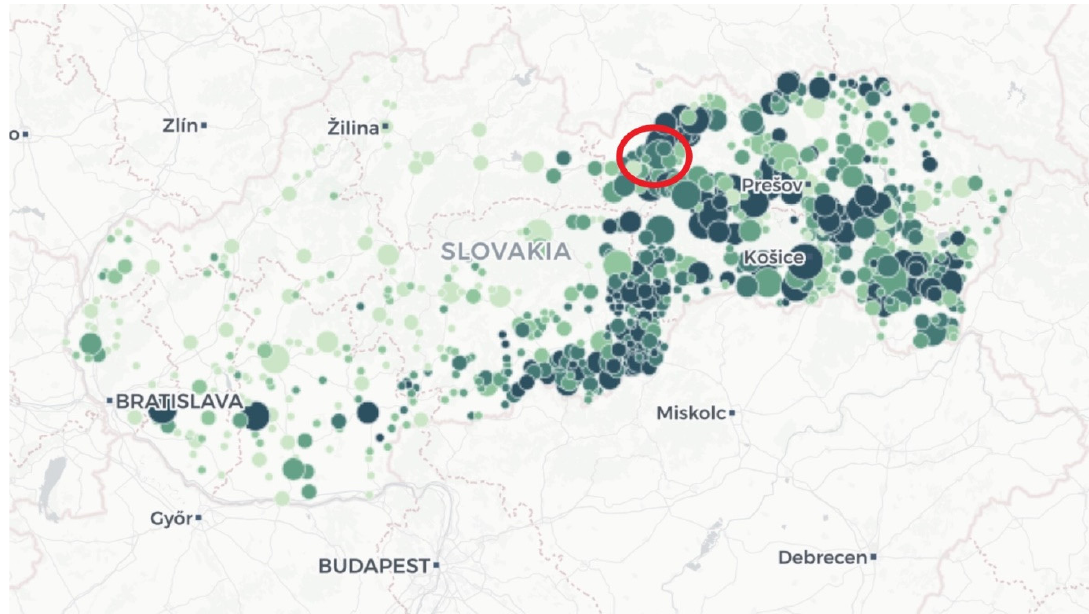
Figure 2. Where do Roma live? Slovakia, showing the district of Poprad (red circle). Source: Kerekes, 2019 [20] (green dots: the bigger the circle, the larger the number of Roma inhabitants, and darker colour indicates increased Roma population density) and the authors.